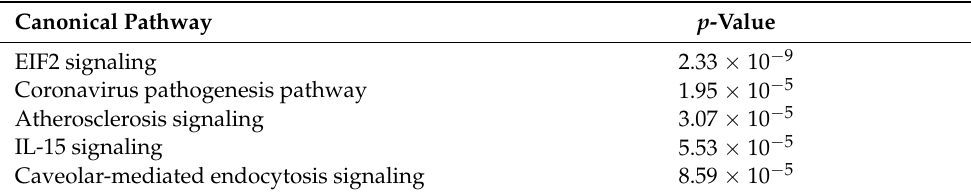
Table 3. The top 5 canonical pathways predicted in Ingenuity Pathway Analysis for differentially expressed genes in sSS-DED patients versus non-SS-DED